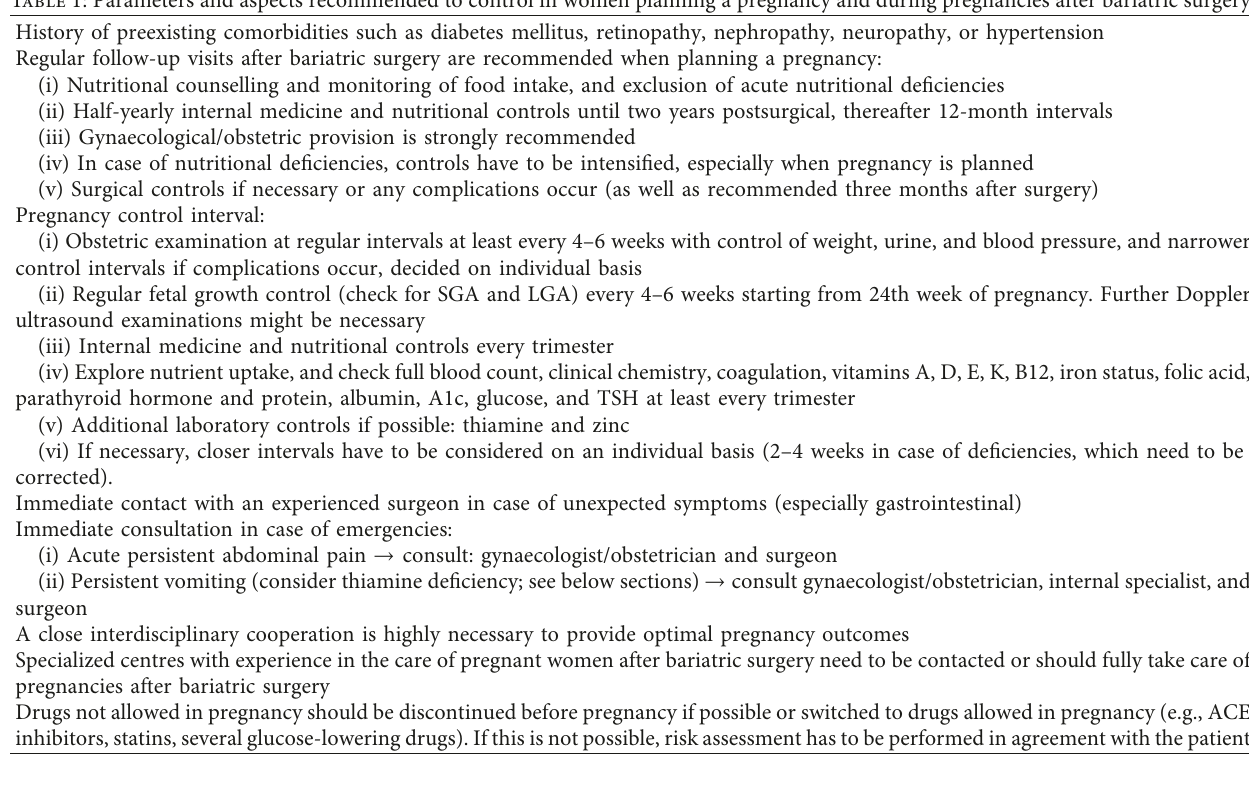
Table 1: Parameters and aspects recommended to control in women planning a pregnancy and during pregnancies after bariatric surgery. History of preexisting comorbidities such as diabetes mellitus, retinopathy, nephropathy, neuropathy, or hypertension Regular follow-up visits after bariatric surgery are recommended when planning a